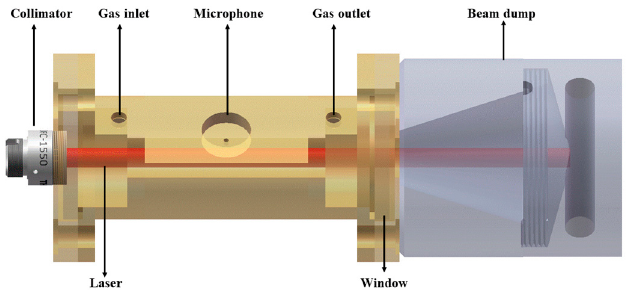
Figure 7. 3-D model of the H-type gold-plated photoacoustic cell, the laser entrance port, and the beam dump.